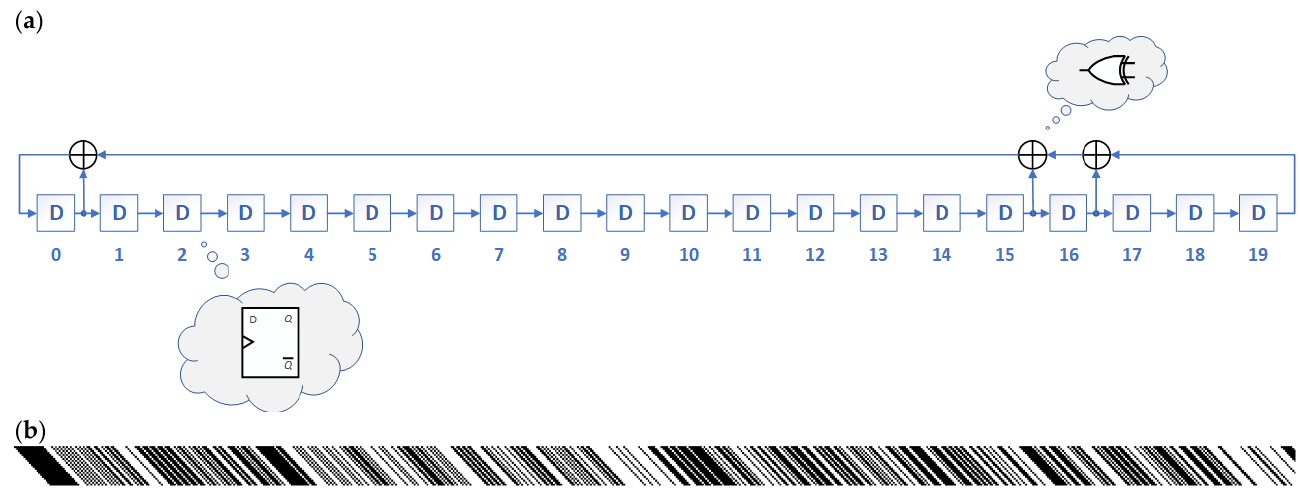
Figure 3. Type I LFSR register associated with the primitive polynomial p ( x ) = 1 + x 3 + + x 4 + x 19 + x 20 : ( a ) Internal structure of the register; ( b ) State-Time Diagram (STD) for that register.